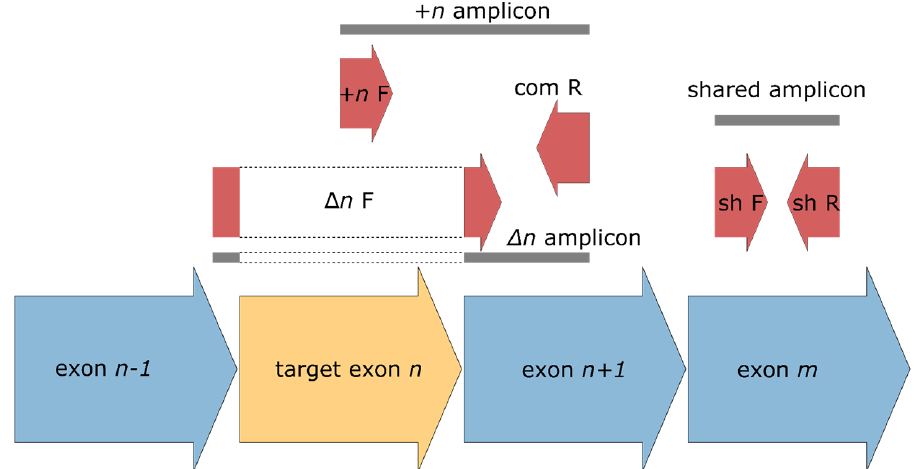
Figure 4. Schematic of primer selection for qPCR. Primers and the corresponding amplicons are shown in red and gray colors, respectively. Δ n corresponds to an isoform with skipped target exon n , while +n means inclusion of the same exon. ‘com’ means the primer common for both isoform-specific amplicons, while the primers corresponding to the shared amplicon (used for intensity normalization) are designated as ‘sh’. F stands for forward primers and R for reversed ones.